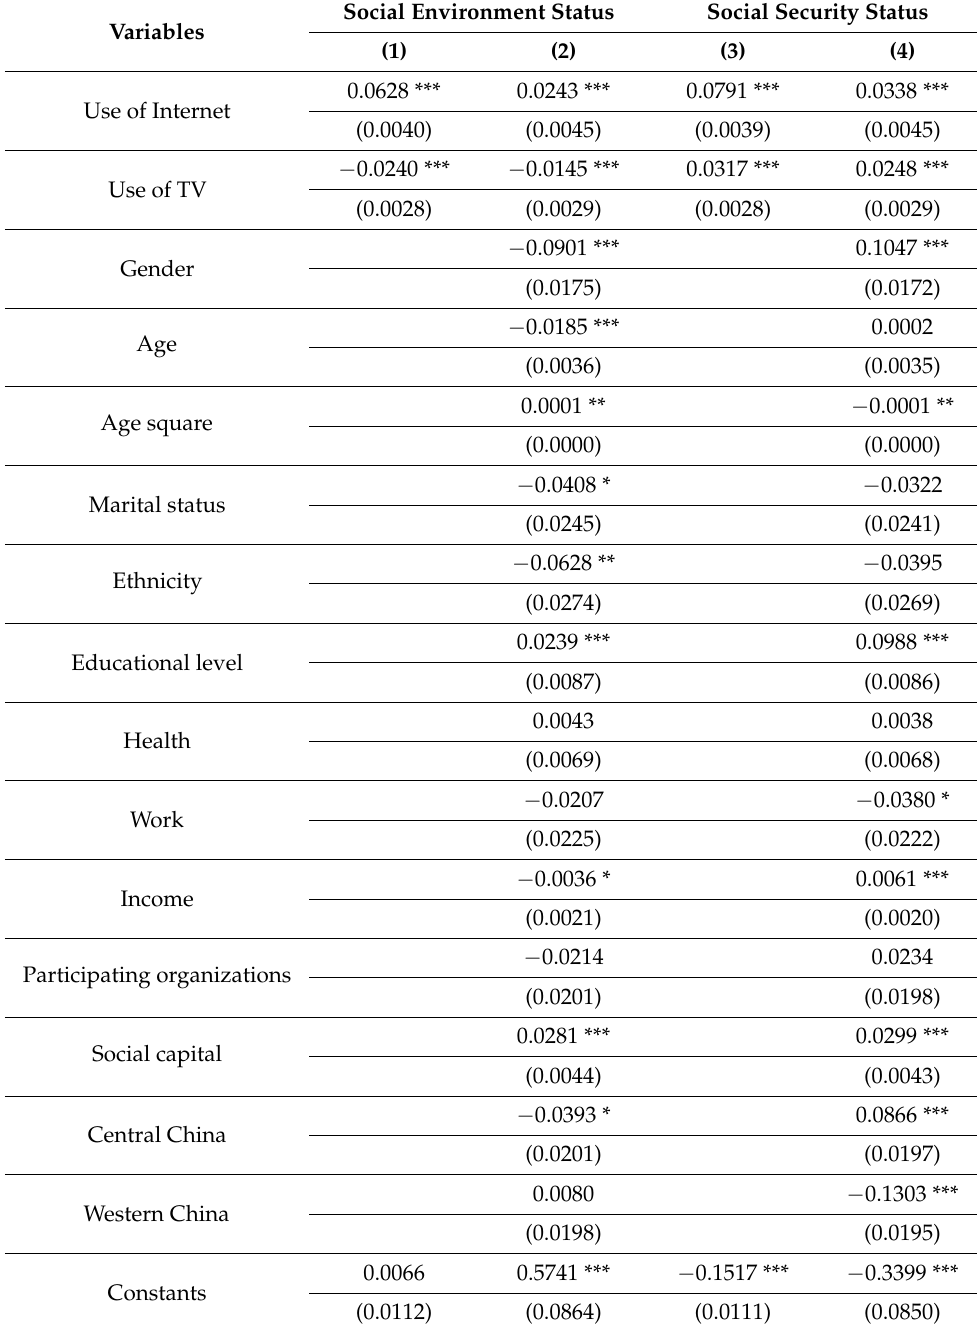
Table 6. Regression results of the principal component and factor